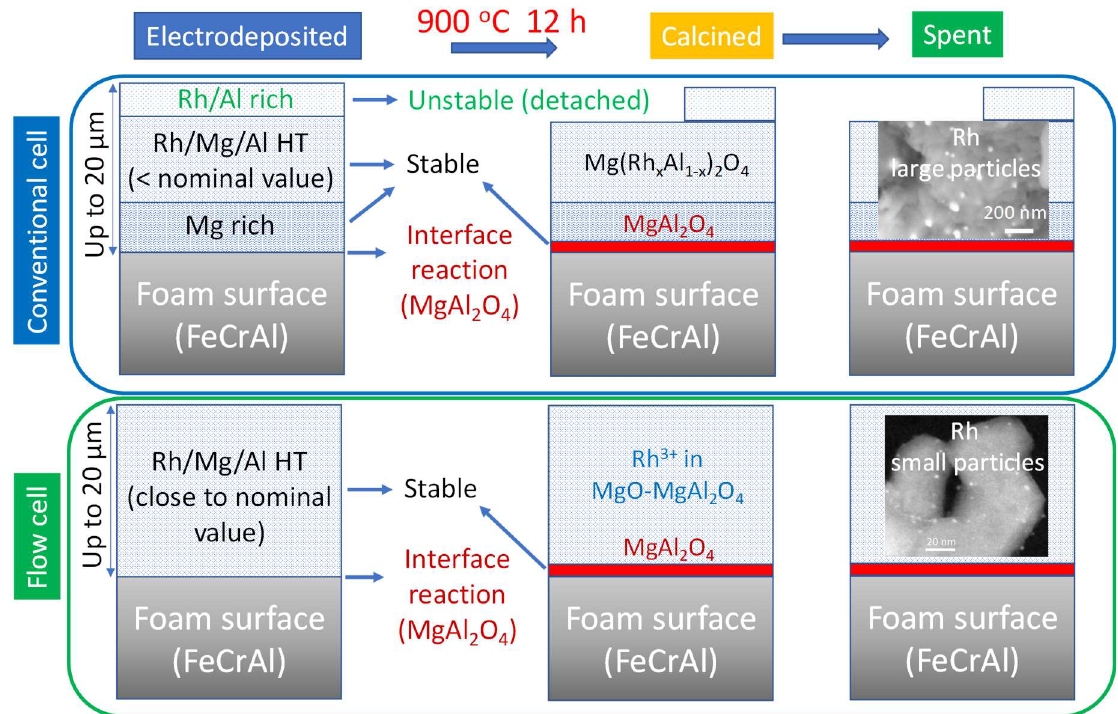
Figure 9. Model of Rh/Mg/Al HT layers electrodeposited on FeCrAl foam in a conventional cell (single compartment) and a flow cell (double-compartment) through the life-time of the catalysts from electrodeposition to the spent state after using for the CPO of CH 4 .